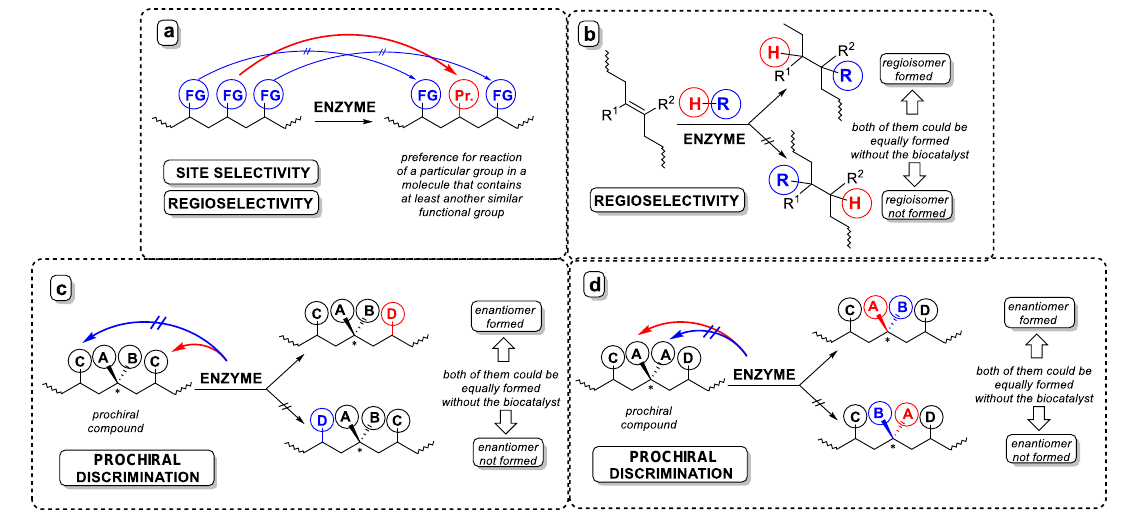
Figure 3. Schematic representation of enzymatic recognition capability for polyfunctional substrates: ( a ) regioselectivity (usually denoted as site selectivity) in transforming certain functional groups (FG, in blue) into a product (Pr in red) without altering others; ( b ) regioselectivity upon addition of an asymmetric reagent (R–H) to an asymmetric double bond; ( c ) prochiral discrimination by transforming only a functional group adjacent to the stereogenic center; ( d ) prochiral discrimination by transforming only a functional group directly attached to the pro-stereogenic center.